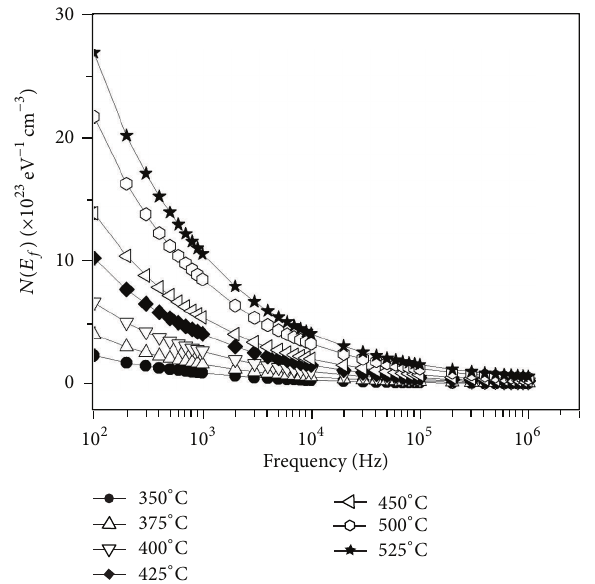
Figure9:VariationofdensityofstatesatFermilevelofPGTceramic with frequency.